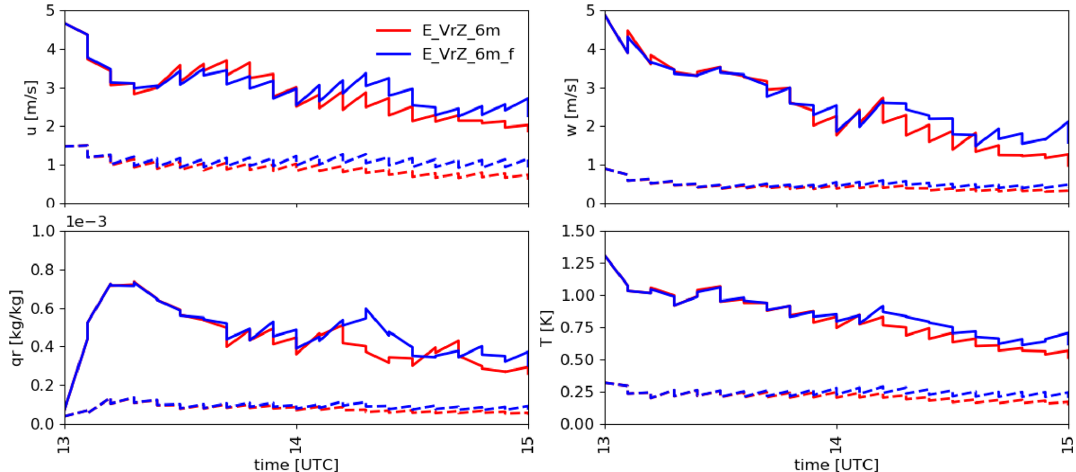
Figure 5. The RMSEs (solid line) and spreads (dashed line) of the deterministic background and analysis (sawtooth pattern) for u , w , q r and